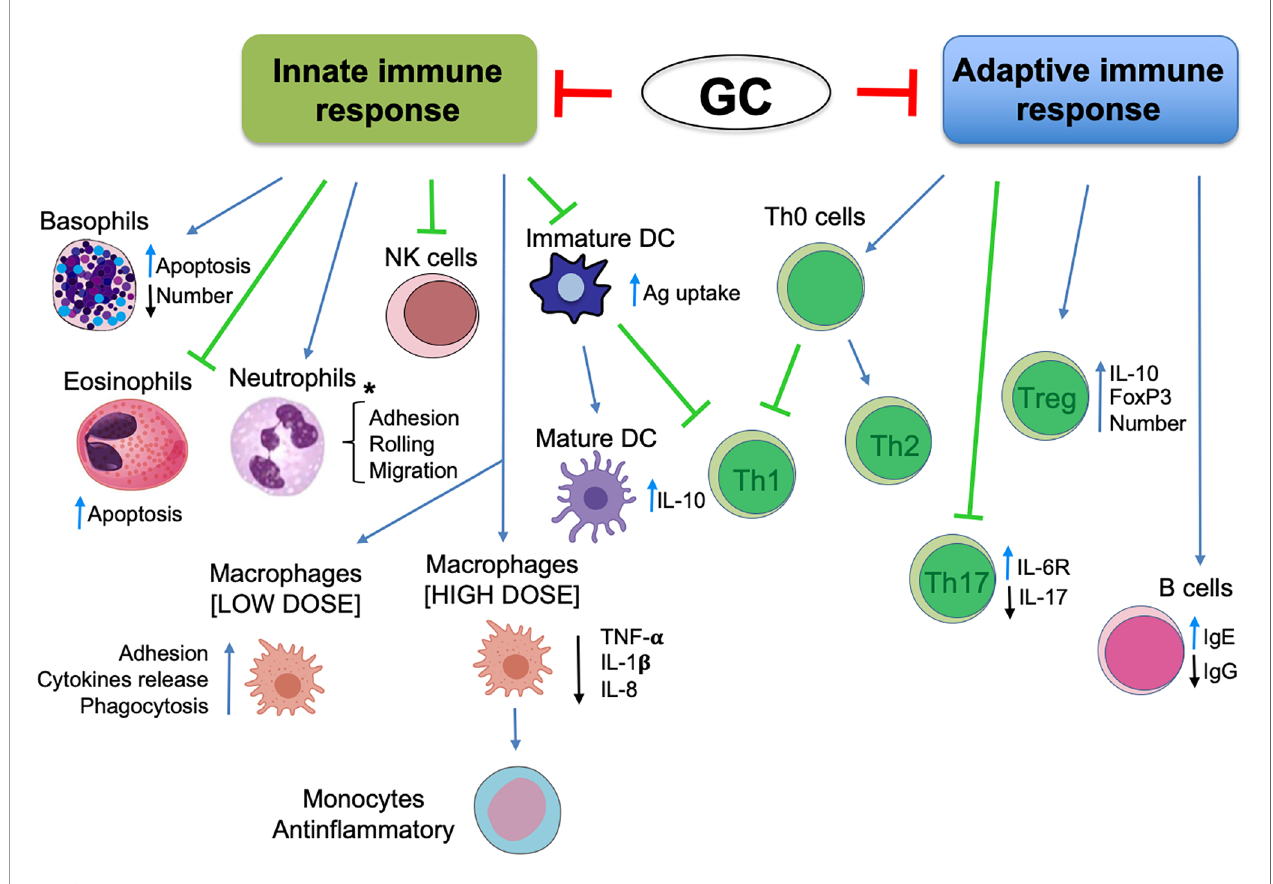
FIGURE 1 | Glucocorticoid effects in innate and adaptive immune response